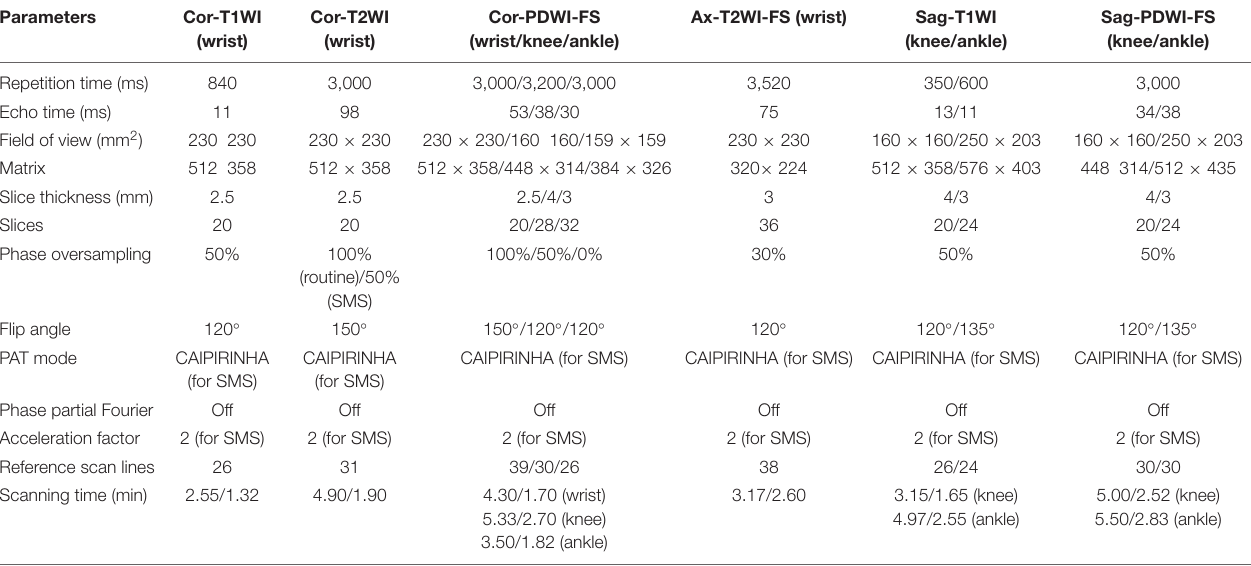
TABLE 1 | Magnetic resonance imaging parameters of the conventional and simultaneous multi-slice sequences.